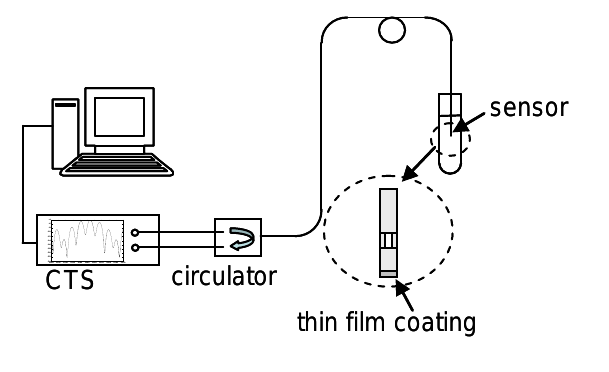
Figure 3. Schematic of multicavity FP sensor system for biosensing